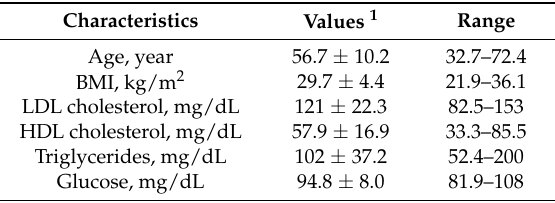
Table 1. Baseline characteristics of the 10 male and eight female participants who consumed control or almond diets, each for three weeks.